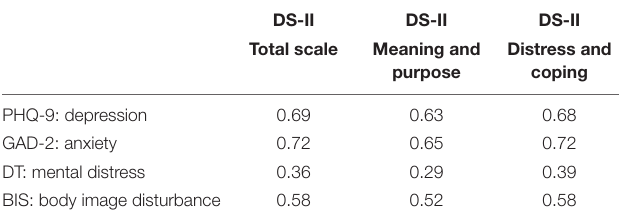
TABLE 4 | Correlations between demoralization and other variables of psychological